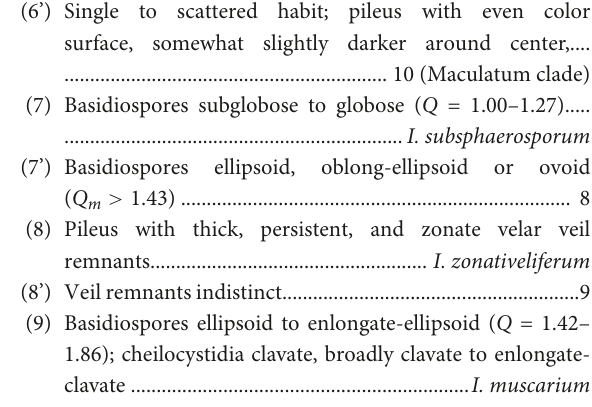
(4’) Pileus with even color surface, somewhat slightly